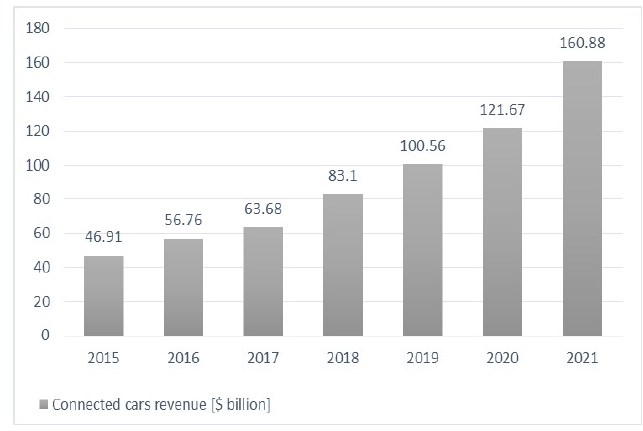
Fig. 2. Global market for connected